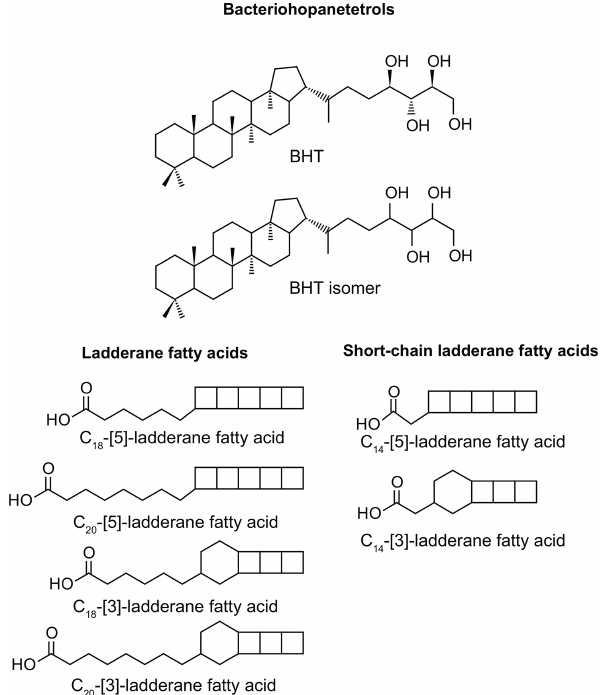
Figure 1. Structures of anammox biomarker lipids used in this study. Bacteriohopanetetrol (BHT); bacteriohopanetetrol stereoiso- mer (BHT isomer), unknown stereochemistry; ladderane fatty acids with 3 or 5 cyclobutane moieties and 18 or 20 carbon atoms; short- chain ladderane fatty acids with 3 or 5 cyclobutane moieties and 14 carbon